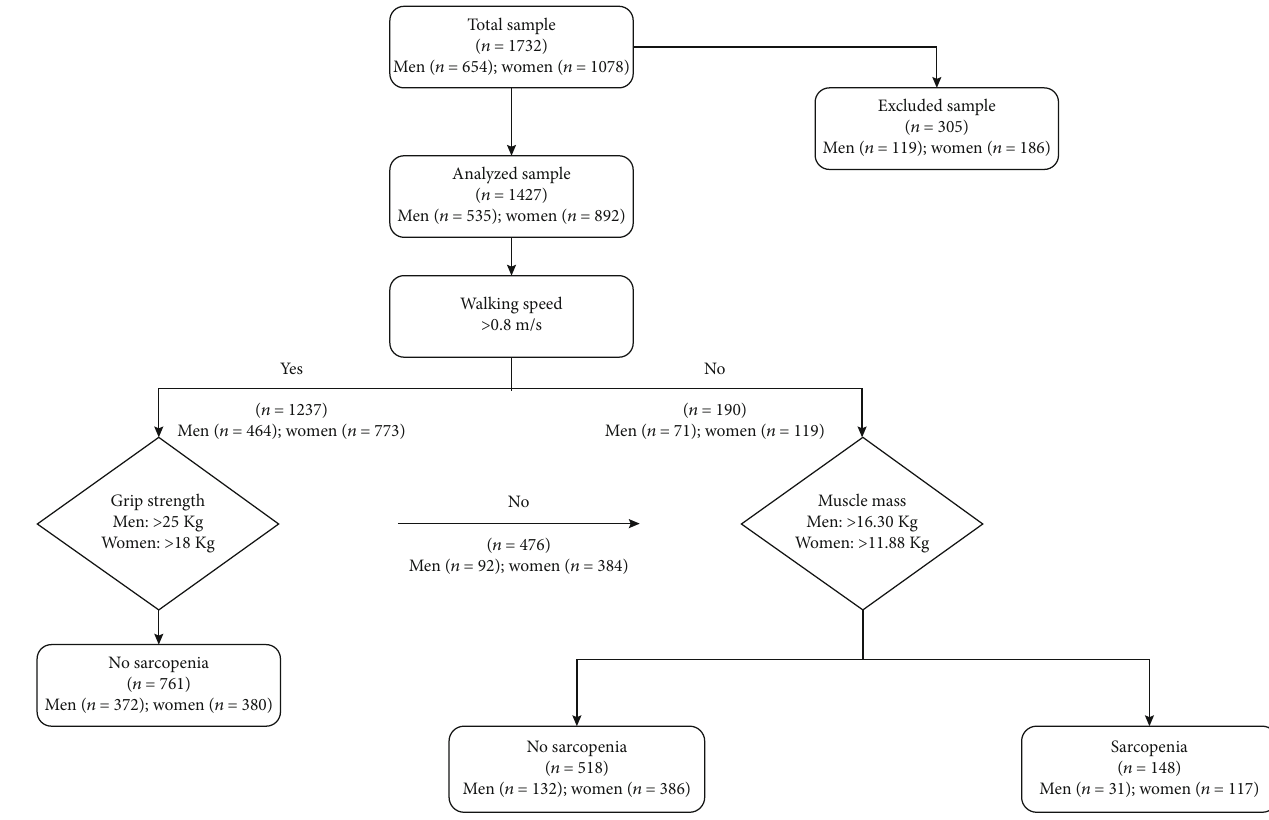
Figure 1: Flow chart of sarcopenia screening and